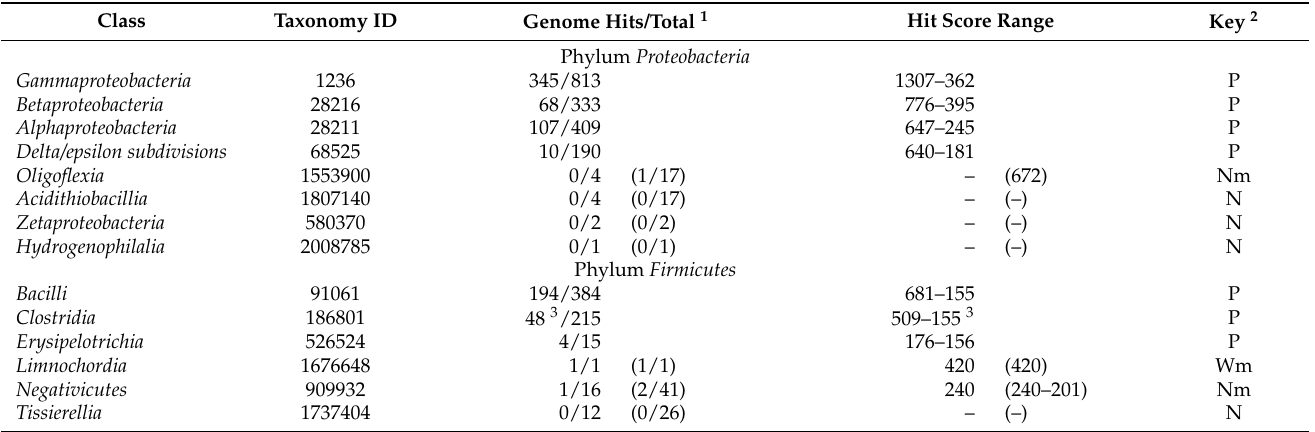
Table 3. Distribution of cpdB -like genes in different classes of phyla Proteobacteria and Firmicutes , as